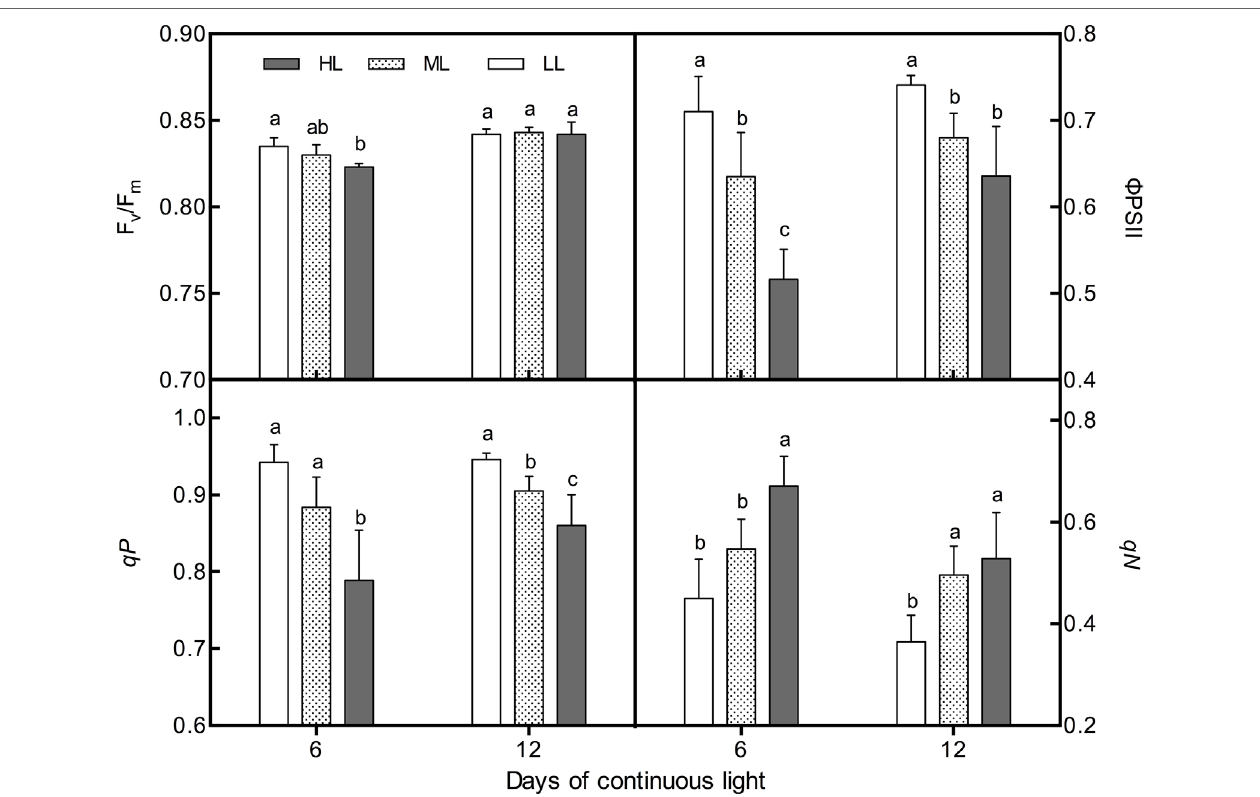
FIgURe 6 | Changes in chlorophyll fluorescence parameters ( F v / F m , qN, qP, and ΦPSII) in lettuce leaves grown under continuous light of different intensities: low light (LL, 100 μmol·m −2 ·s −1 ), medium light (ML, 200 μmol·m −2 ·s −1 ), and high light (HL, 300 μmol·m −2 ·s −1 ). Values are means of four replicates ± SD. Different letters indicate significant differences between different light intensity treatments at p < 0.05 according to Tukey test.